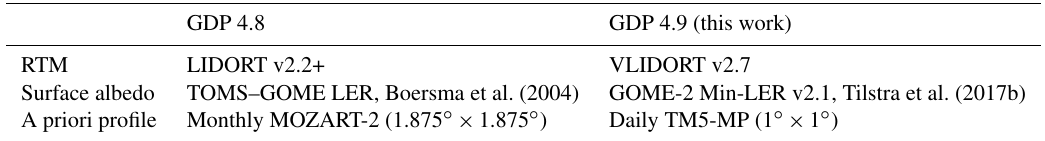
Figure 9. GOME-2 initial total NO 2 columns (a, b) and stratospheric NO 2 columns retrieved from the improved STREAM algorithm (c, d) and from the spatial filtering method used in GDP 4.8 (e, f) , measured by GOME-2A in February (a, c, e) and August (b, d, f) 2009. Table 2. Main settings of AMF calculation method and input data discussed in this